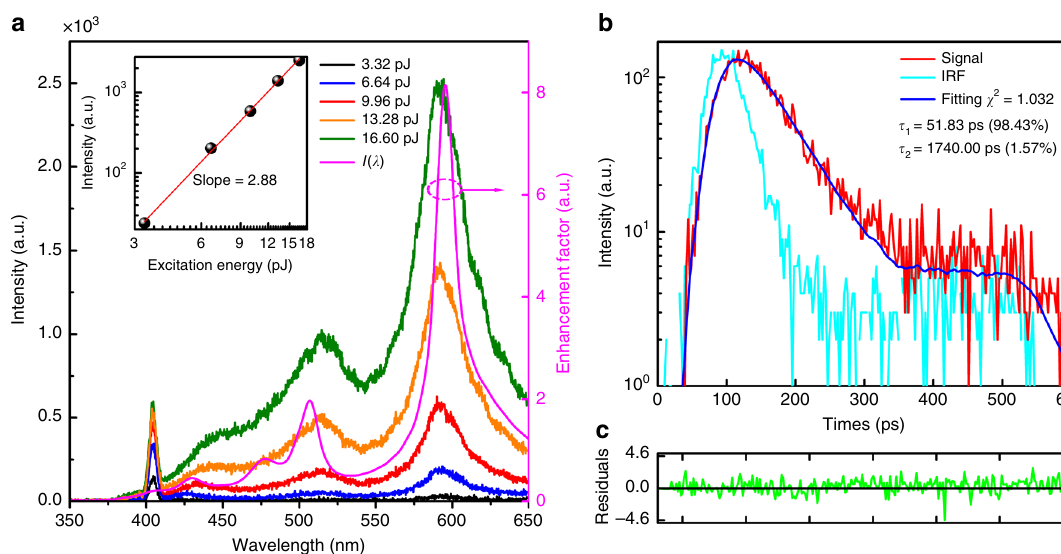
Fig. 3 Emission enhancement and luminescence lifetime. a Nonlinear response spectra measured at different excitation pulse energies for a silicon nanosphere (NS) with d ~210 nm. The spectrum of I calculated for the silicon NS is also presented for comparison. The inset shows the dependence of the up-converted luminescence on the excitation pulse energy plotted in a double-logarithmic coordinate. b Decay of the up-converted luminescence measured for a silicon NS with d ~190 nm after the excitation of the femtosecond laser pulses. The luminescence lifetime is derived to be ~52 ps based on a reconvolution fi tting analysis. Here, IRF represents instrument response function and χ 2 is a parameter characterizing the fi tting quality. c The corresponding residuals for the fi